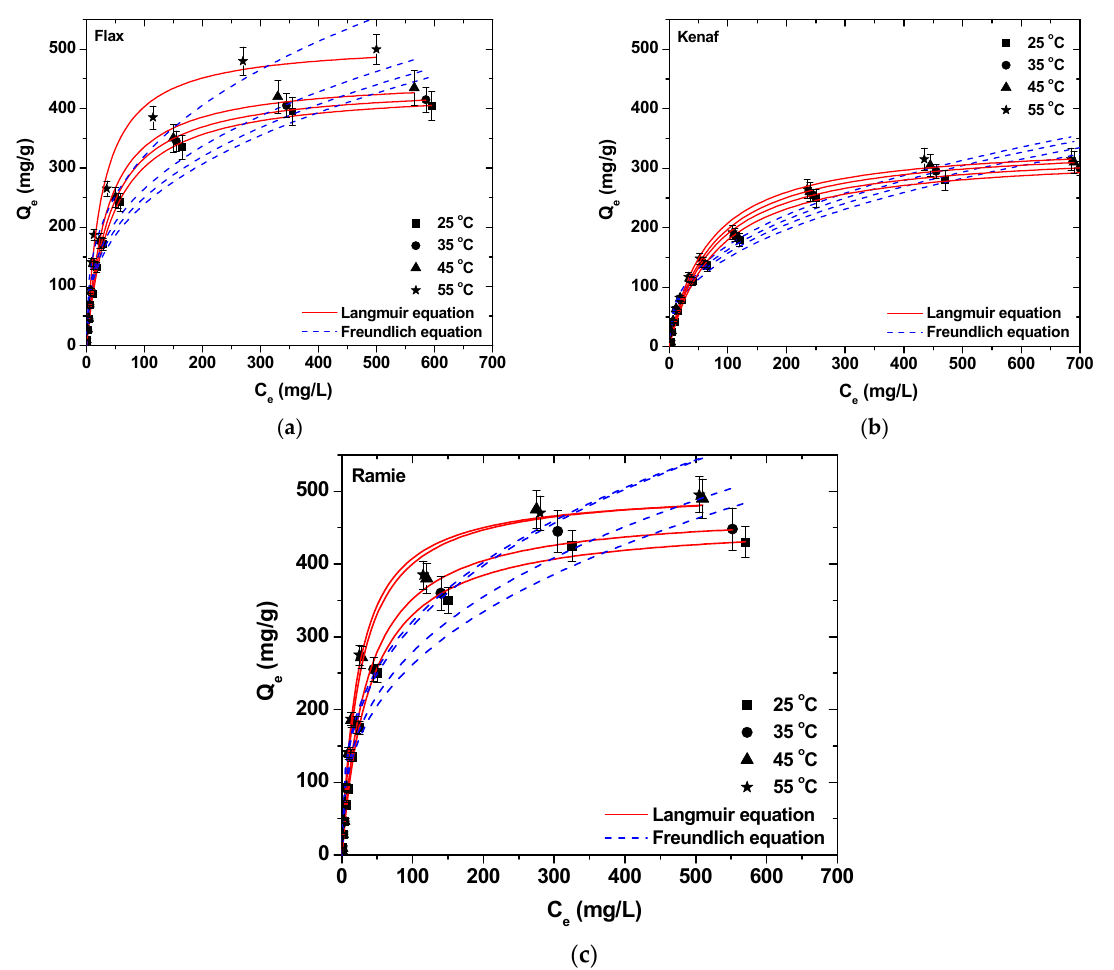
Figure 7. Isotherms for the adsorption of BY37 at 25, 35, 45, and 55 °C onto ( a ) flax, ( b ) kenaf, and ( c ) ramie fibers (adsorption conditions: C 0 = 10–1000 mg·L − 1 , pH = 12, T = 25–55 °C, N = 160 rpm, m = 0.1 g, V = 100 mL, and t = 24 h).